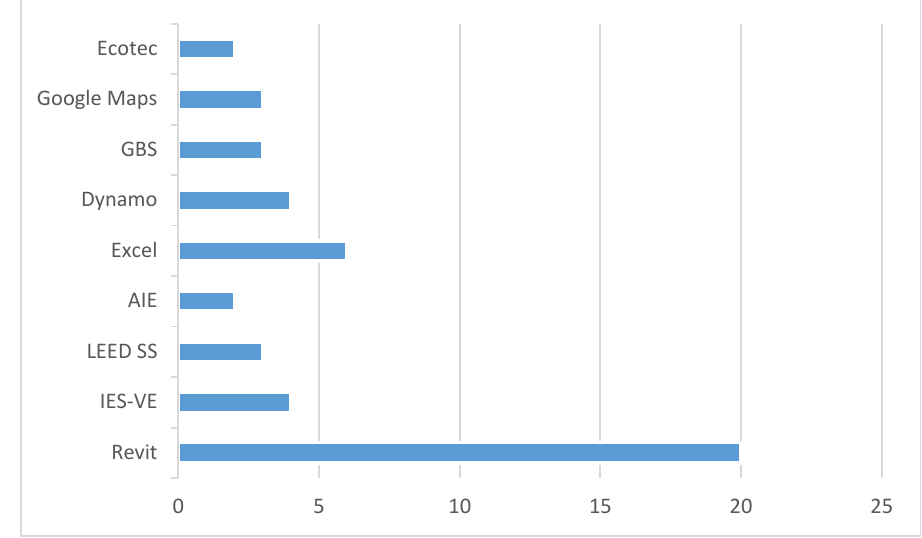
Figure 11. Commonly used software (BREEAM and LEED).